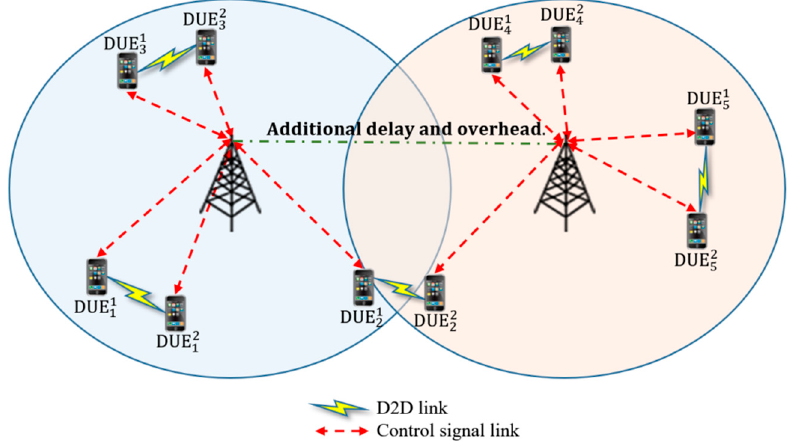
Figure 1. Network environment under consideration.